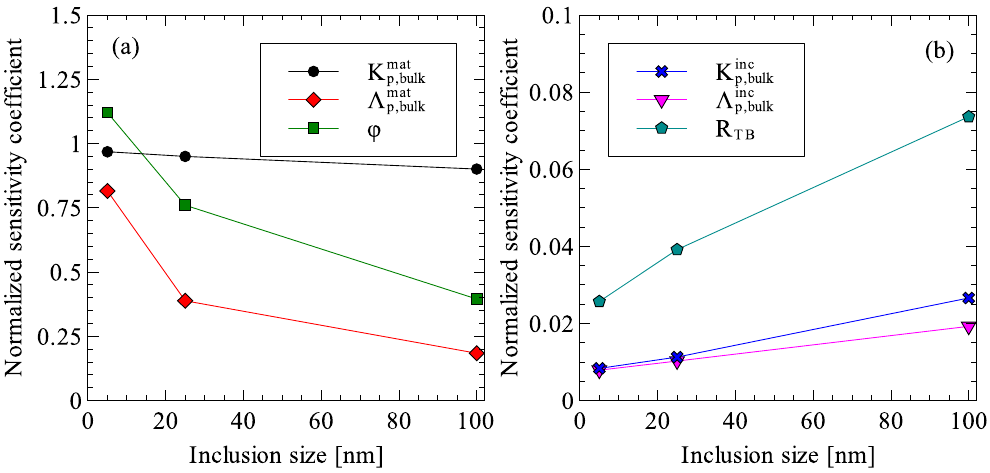
Figure 18. Variation of normalized sensitivity coefficients for: ( a ) bulk matrix thermal conductivity, matrix phonon mean-free-path and inclusion volume fraction; and ( b ) bulk inclusion thermal conductivity, inclusion phonon mean-free-path and thermal interface resistance.